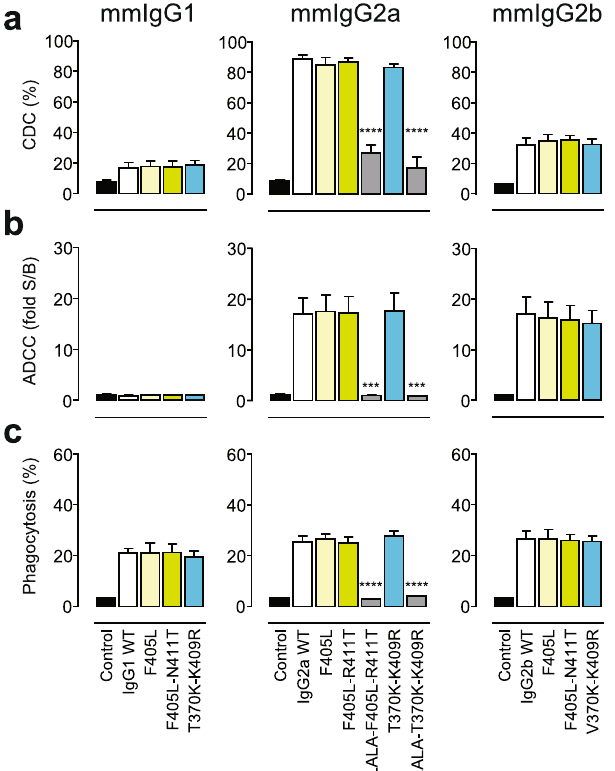
Figure 4. ( a ) CDC of Raji cells incubated with a fixed 10 μ g/mL concentration of the indicated mmIgG1 (left), mmIgG2a (middle), or mmIgG2b (right) variants of mAb 7D8 in the presence of 20% (v/v) pooled human serum. ( b ) Surrogate ADCC activity of Jurkat-NFAT-mFc γ RIV effector (E) cells induced by Raji target (T) cells incubated with a fixed 3 μ g/mL concentration of the indicated variants (see A), with an E:T ratio of 1:1. ( c ) Phagocytosis of Daudi cells (T) by bone marrow-derived mouse macrophages (E) incubated with a fixed 1 μ g/mL concentration of the indicated variants (see A), with an E:T ratio of 1:1. Data represent mean ± SEM of at least three experiments. Statistical significance (compared to WT) was determined by one-way ANOVA ( *** P < 0.001; **** P <